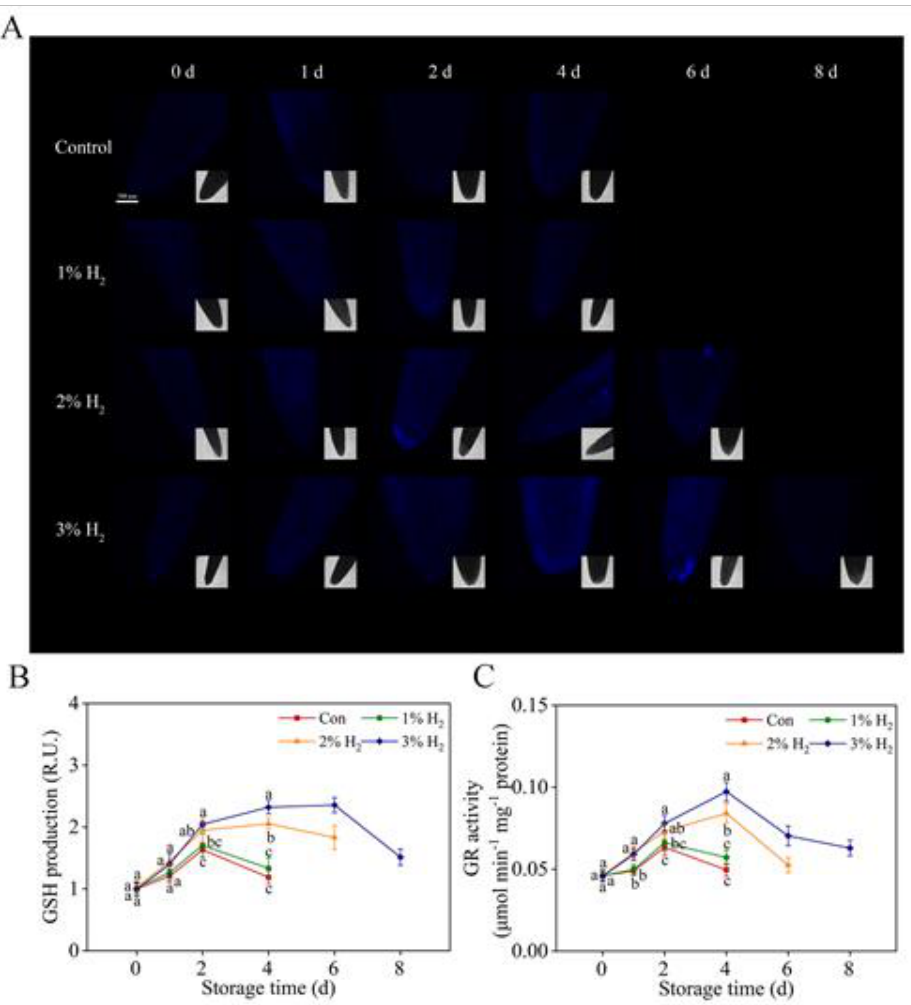
Figure 6. Changes in reduced glutathione (GSH) content and GR activity. The LSCM images of monochlorobimane (MCB)-dependent fluorescence in chive leaf apex were used to represent reduced GSH contents ( A ) and the relative fluorescence was presented as values relative to Con at 0 day ( B ). Meanwhile, time-dependent changes in GR activity ( C ) were determined. Means ± SE ( n = 5 for LSCM imaging and GR activity, respectively) followed by different letters for each storage time indicate a statistical difference at p <0.05. Scale bar = 500 μm.